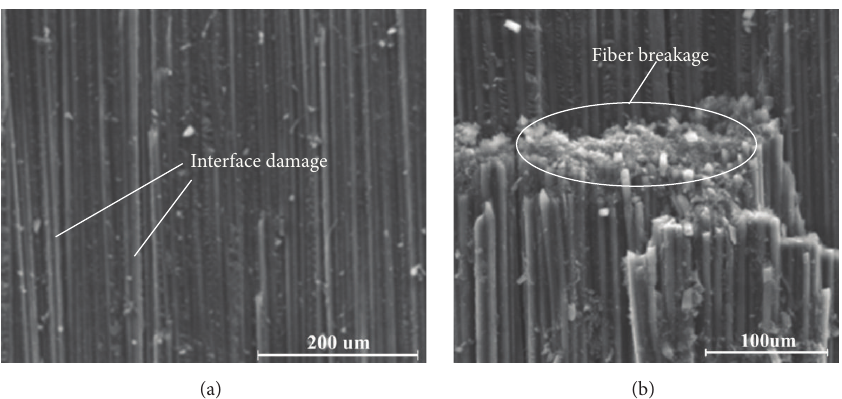
Figure 6: Micromorphology of damage modes in tensile specimen: (a) interface damage (AE amplitude ≥ 60dB and ≤ 70dB); (b) fiber breakage (AE amplitude ≥ 70 dB and ≤ 100